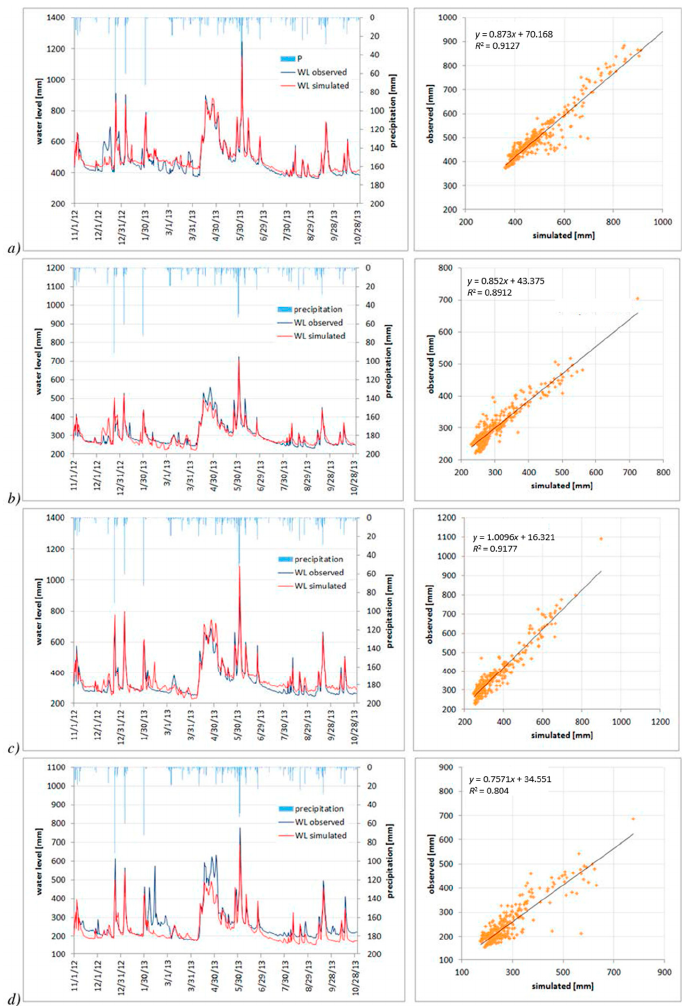
Figure 6. Model validation in a complex hydrological year, 1 November 2012–31 October 2013